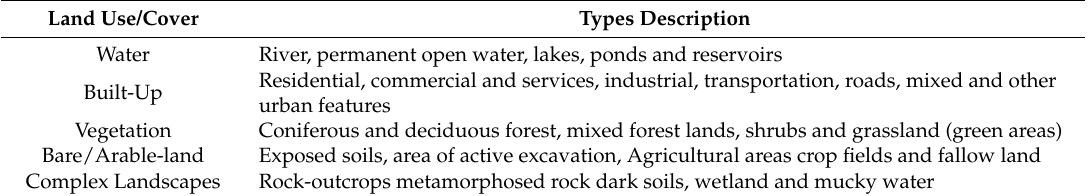
Table 3. Land cover classes used in the